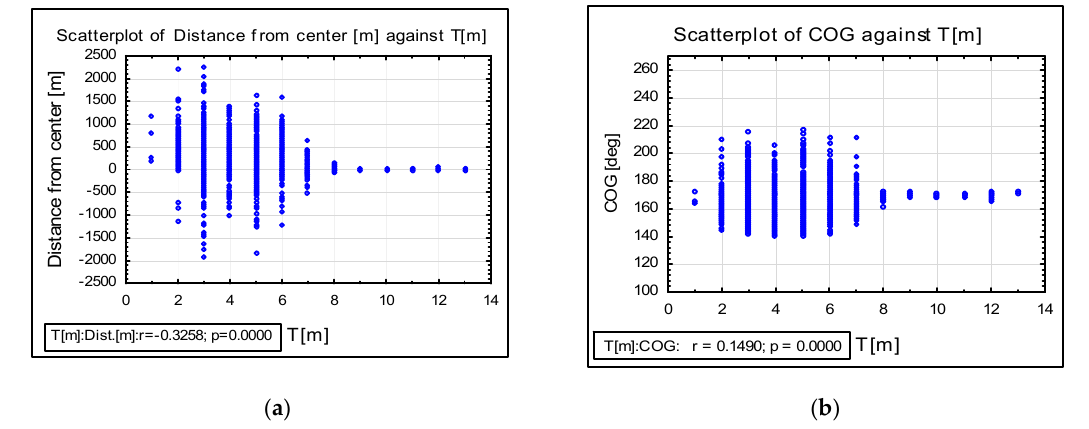
Figure 12. ( a ) Scatterplot of distance from centre versus draught T . ( b ) Scatterplot of COG versus draught T .